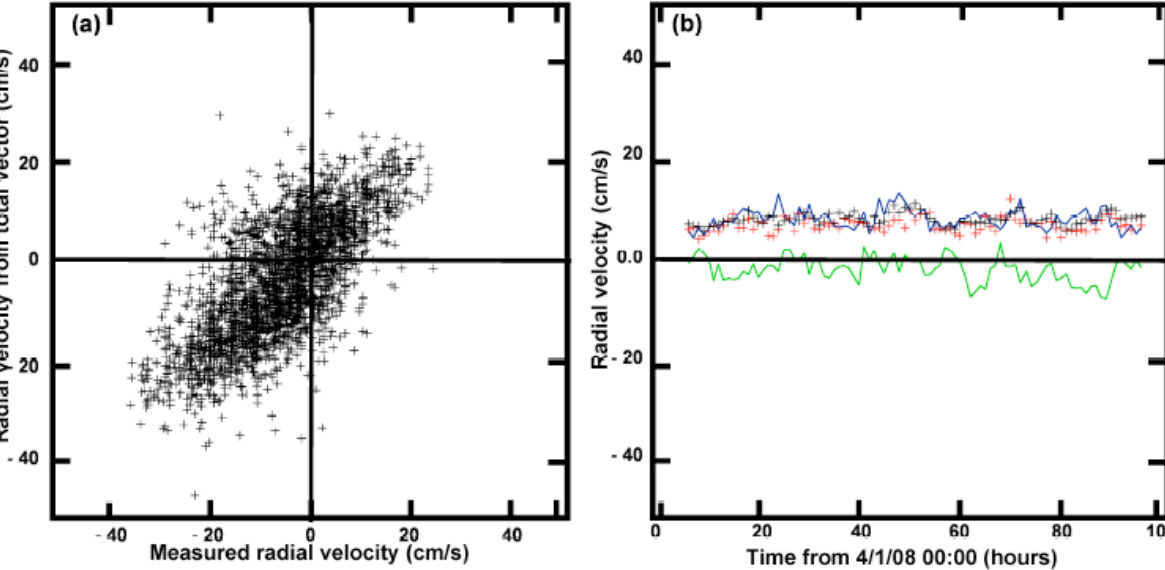
Figure 17. (a) Scatter plot of radial velocity data points: Radial velocity from COMM/FORT totals vs DRAK radial velocity; (b) Comparison statistics averaged over the map, plotted vs. time: Blue –standard deviation between DRAK radials and radials from COMM/FORT total velocities. Green—bias. Red—spatial standard deviation in DRAK radials Black—temporal standard deviation in DRAK